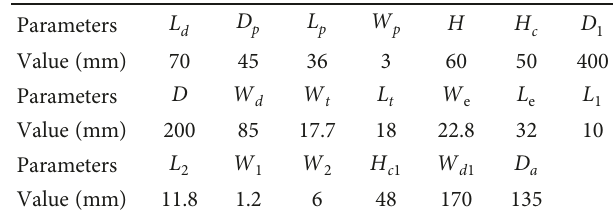
Table 1: Parameters of